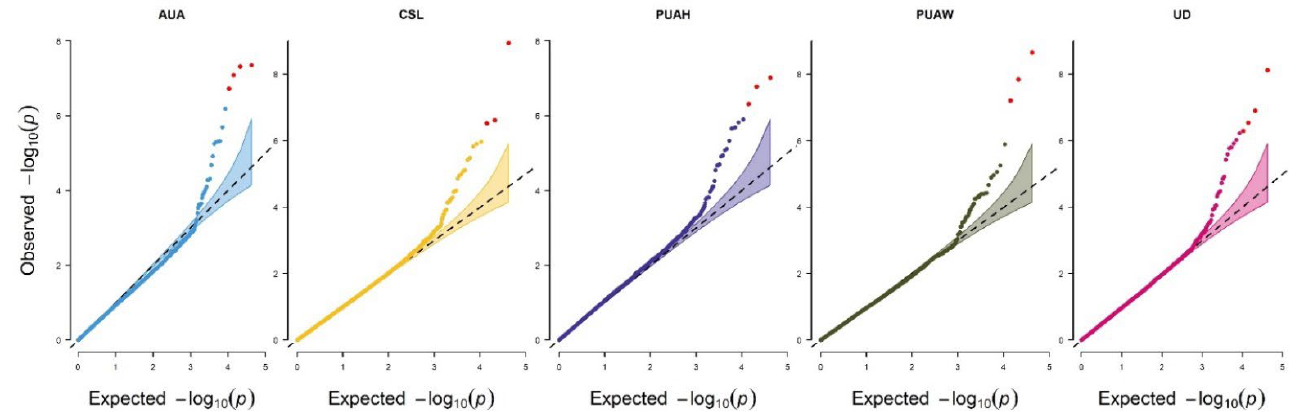
Table 3. GWAS significant SNPs associated with udder structure conformation traits in Holstein cattle.